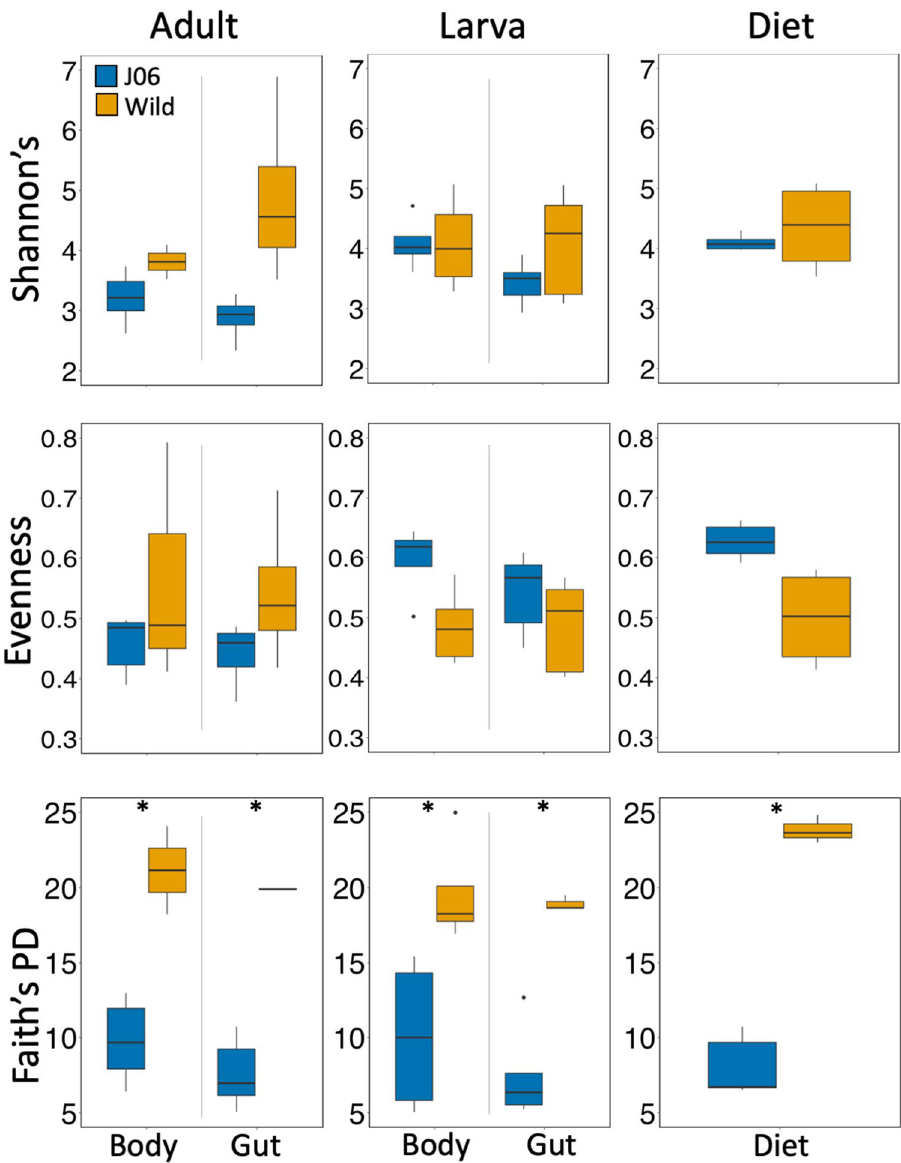
Figure 1. Comparisons of alpha diversity measures (Shannon’s diversity, Pielou’s evenness, and Faith’s PD) by sample type. Significant pairwise differences within sample type are indicated with